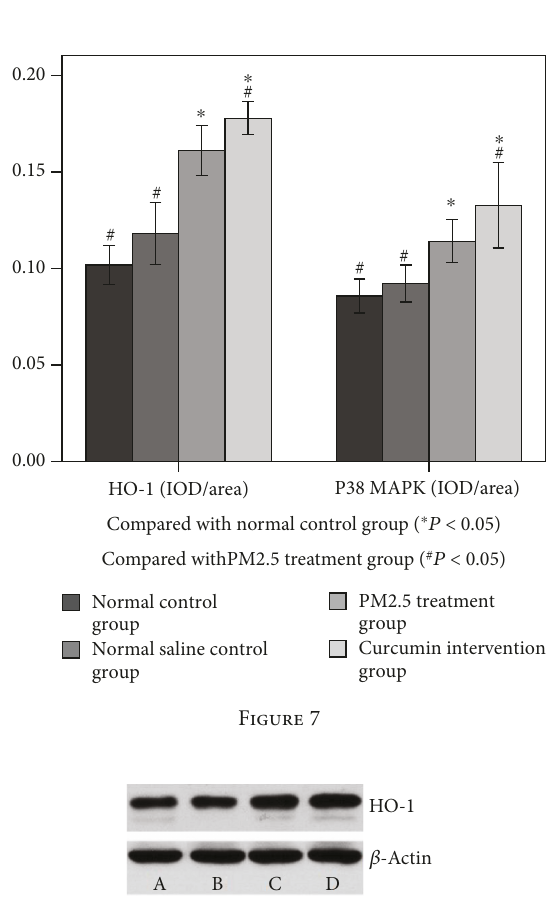
Figure 8: Western blot